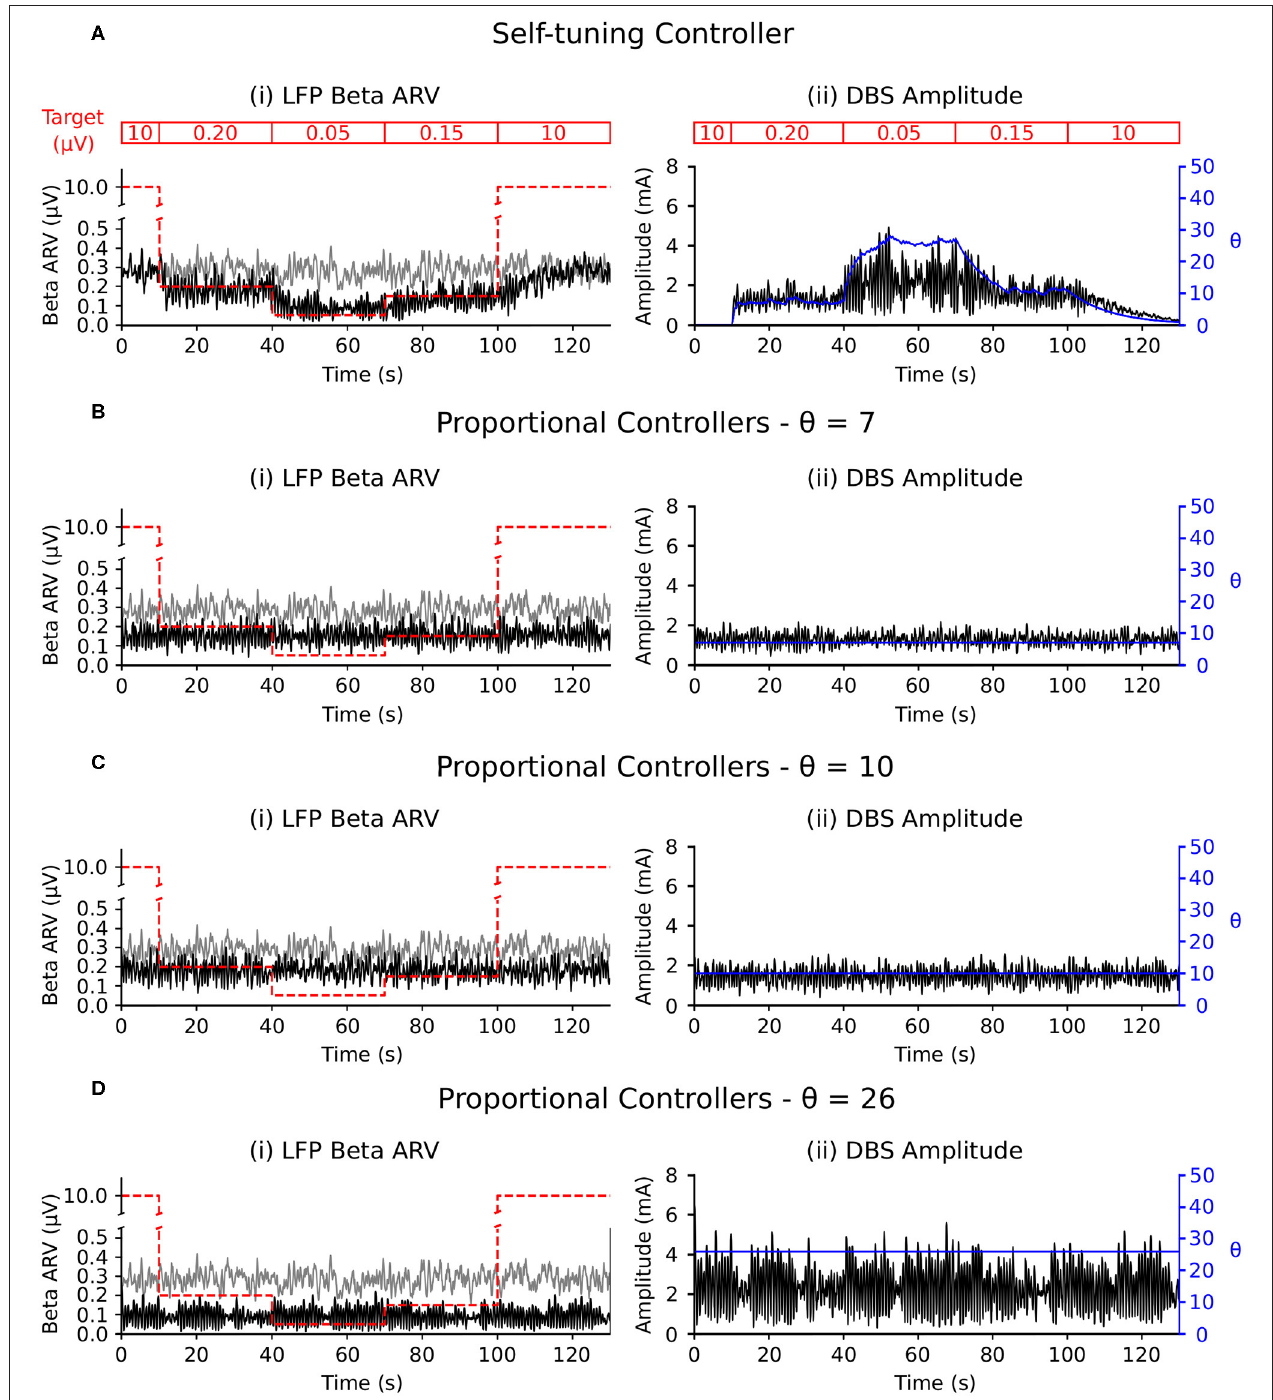
FIGURE 6 | Performance comparison of self-tuning and proportional controllers in response to beta ARV target variations in the conductance-based model. Background beta-band activity in the model was fixed to its maximum value for the duration of the simulation while the target value was modulated to 10, 0.20, 0.05, 0.15, and 10 µ V during the 0–10, 10–40, 40–70, 70–100, and 100–130 s time periods, respectively. The target value for each time period is highlighted by the red segmented bar at the top of the figure. Left panels illustrate the target value (dashed red), the beta ARV measured from the STN LFP when DBS was off (gray) or on (black), where the DBS amplitude is modulated by the corresponding controller. Right panels illustrate the time evolution of the DBS amplitude (black) and controller gain θ (blue) during simulation. (A) Self-tuning DBS controller with τ θ = 100 ms and σ = 0.00875. (B) Proportional controller with a fixed gain value of θ = 7. (C) Proportional controller with a fixed gain value of θ = 10. (D) Proportional controller with a fixed gain value of θ = 26.